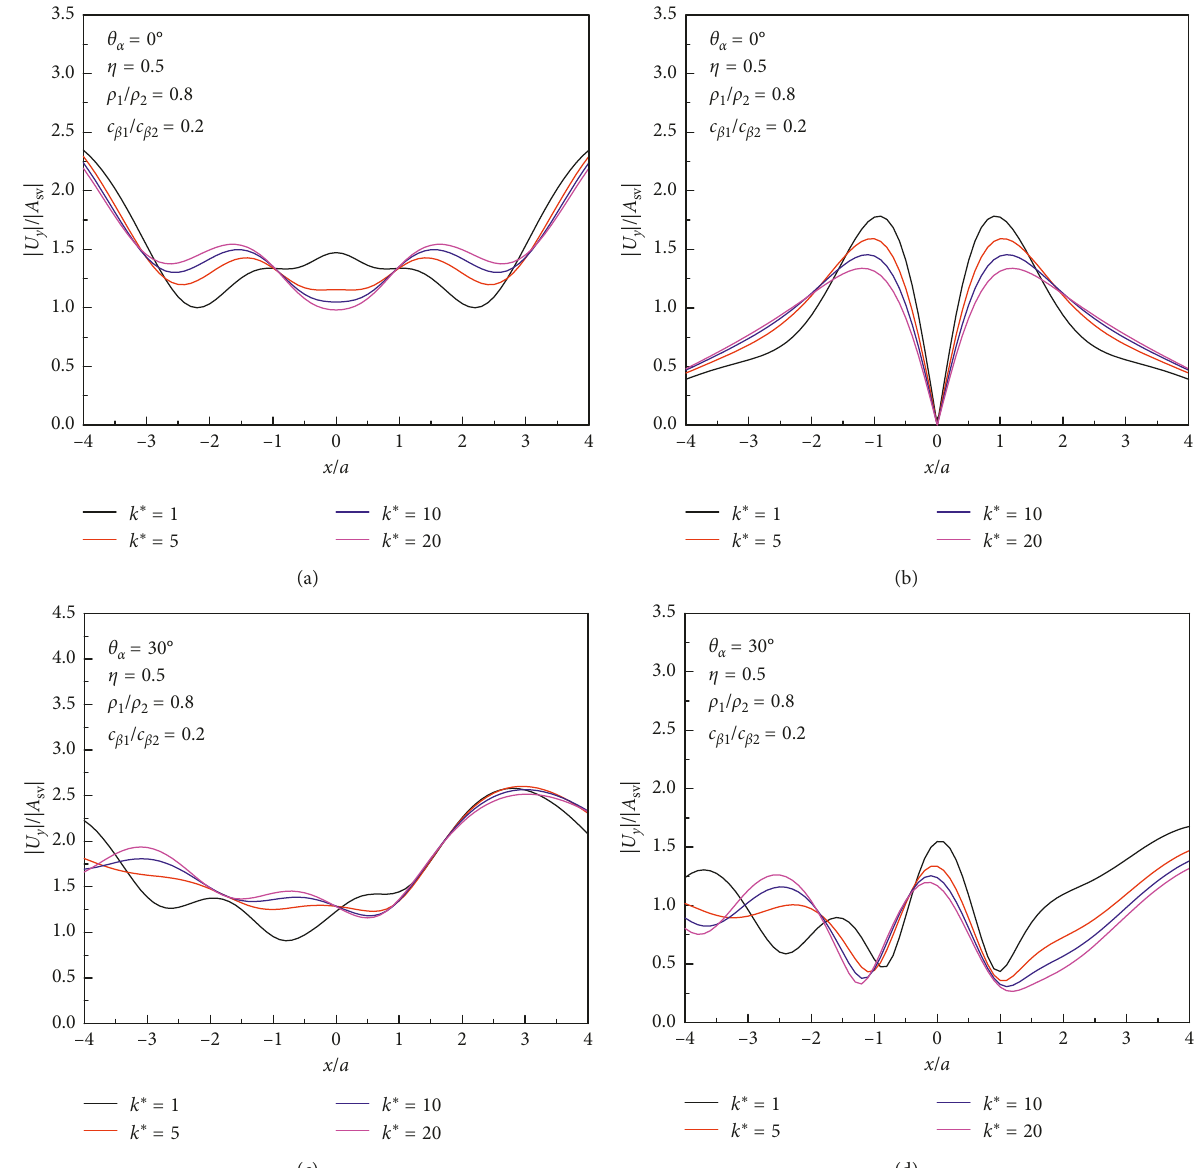
Figure 12: Surface displacement amplitude near tunnel lining under the incident SV wave ( η amplitude; (b) surface vertical displacement amplitude; (c) surface horizontal displacement amplitude; (d) surface vertical displacement